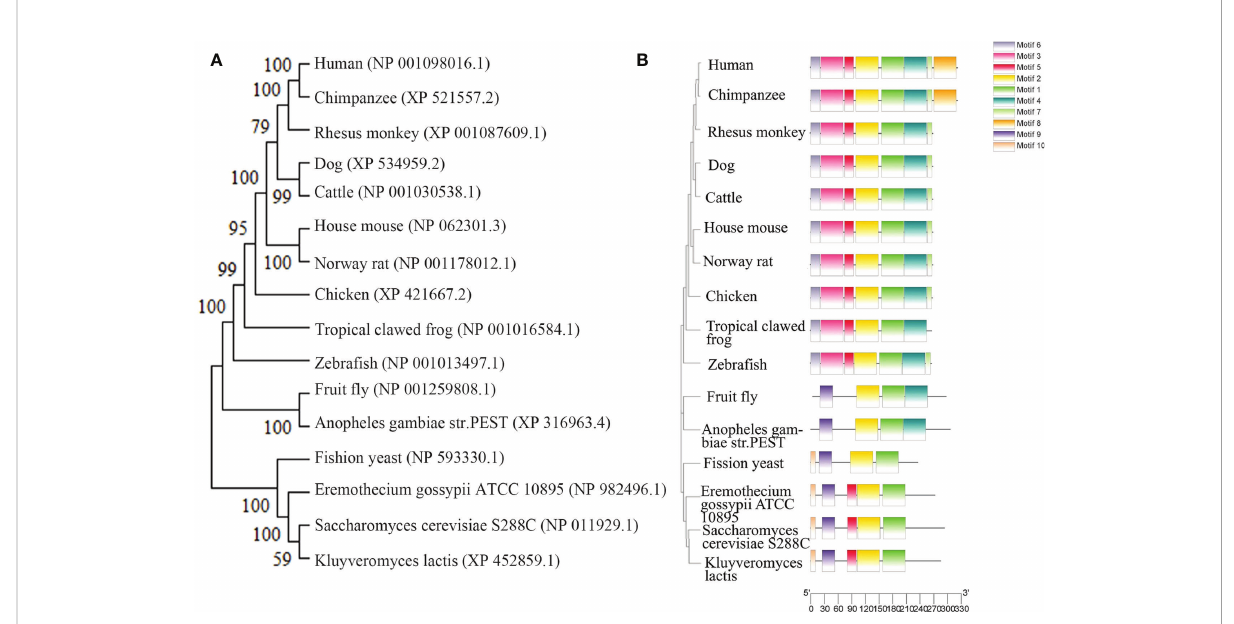
FIGURE 1 Homology of ribonuclease P protein (RPP) in various species. (A) Homologous evolutionary tree, (B) Human RPP30 protein subunit, and homologous protein subunits of other